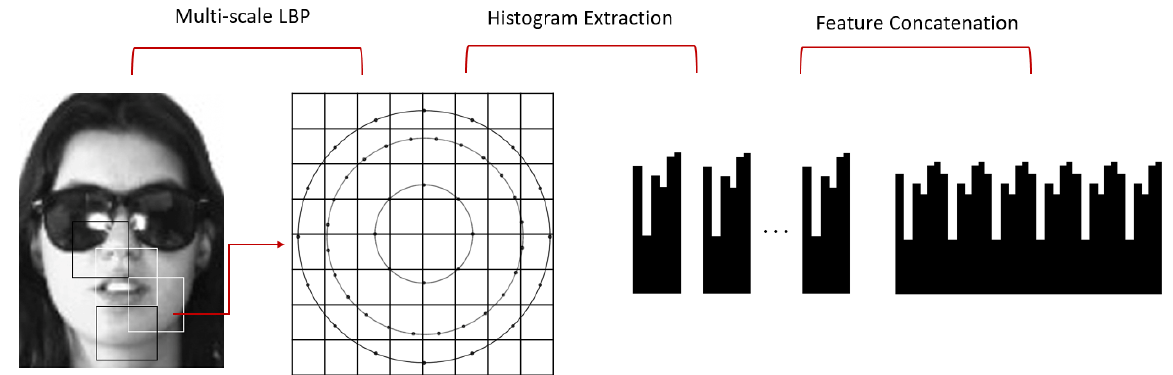
Figure 4. The process of extracting multi-LBP features from face